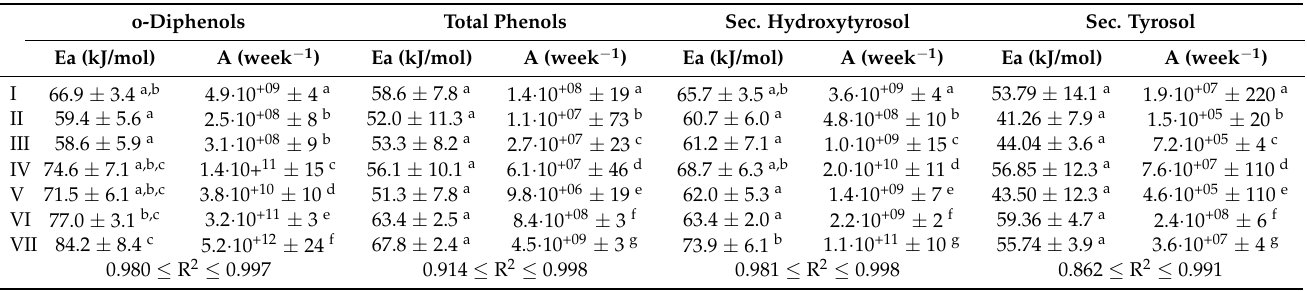
Table 3. Linear Arrhenius kinetics of of complex phenols fitted to a pseudo-first-order reaction: k = A · e Ea/RT